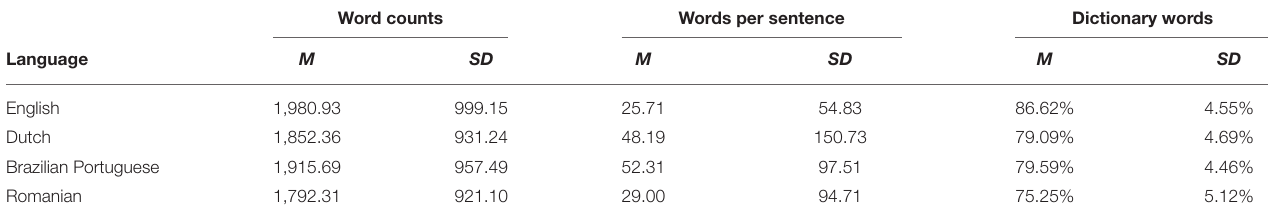
TABLE 3 | The composition of the transcripts based on the LIWC2015 tokenizer. Word counts Words per